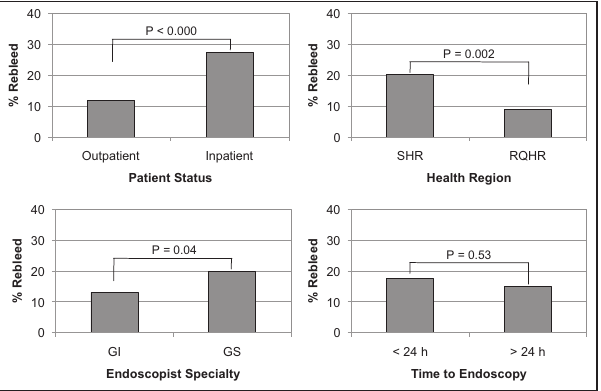
Figure 2) Thirty-day rebleed events in patients presenting with nonvariceal upper gastrointestinal bleeding in the Saskatoon Health Region (SHR) and Regina Qu’Appelle health region (RQHR) stratified according to patient status, health region, endoscopist specialty and time to endoscopy. The level of statistical significance is indicated by the given P values. GI